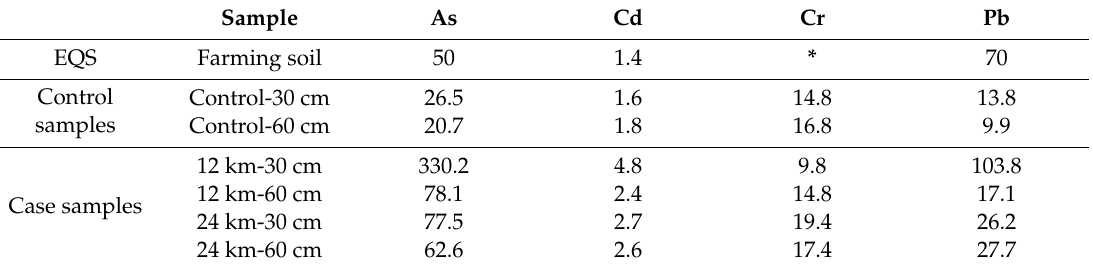
Table 7. Total heavy metal contents (mg Kg − 1 ) in soil samples exceeding EQS in the Cunas